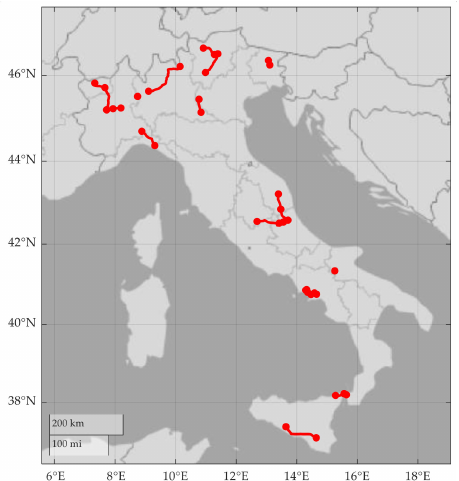
Figure 20. Congested lines identified by N1cor scenario over the entire set of